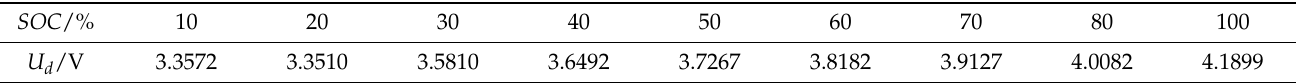
Table 1. The relationship between U d and SOC during the test.